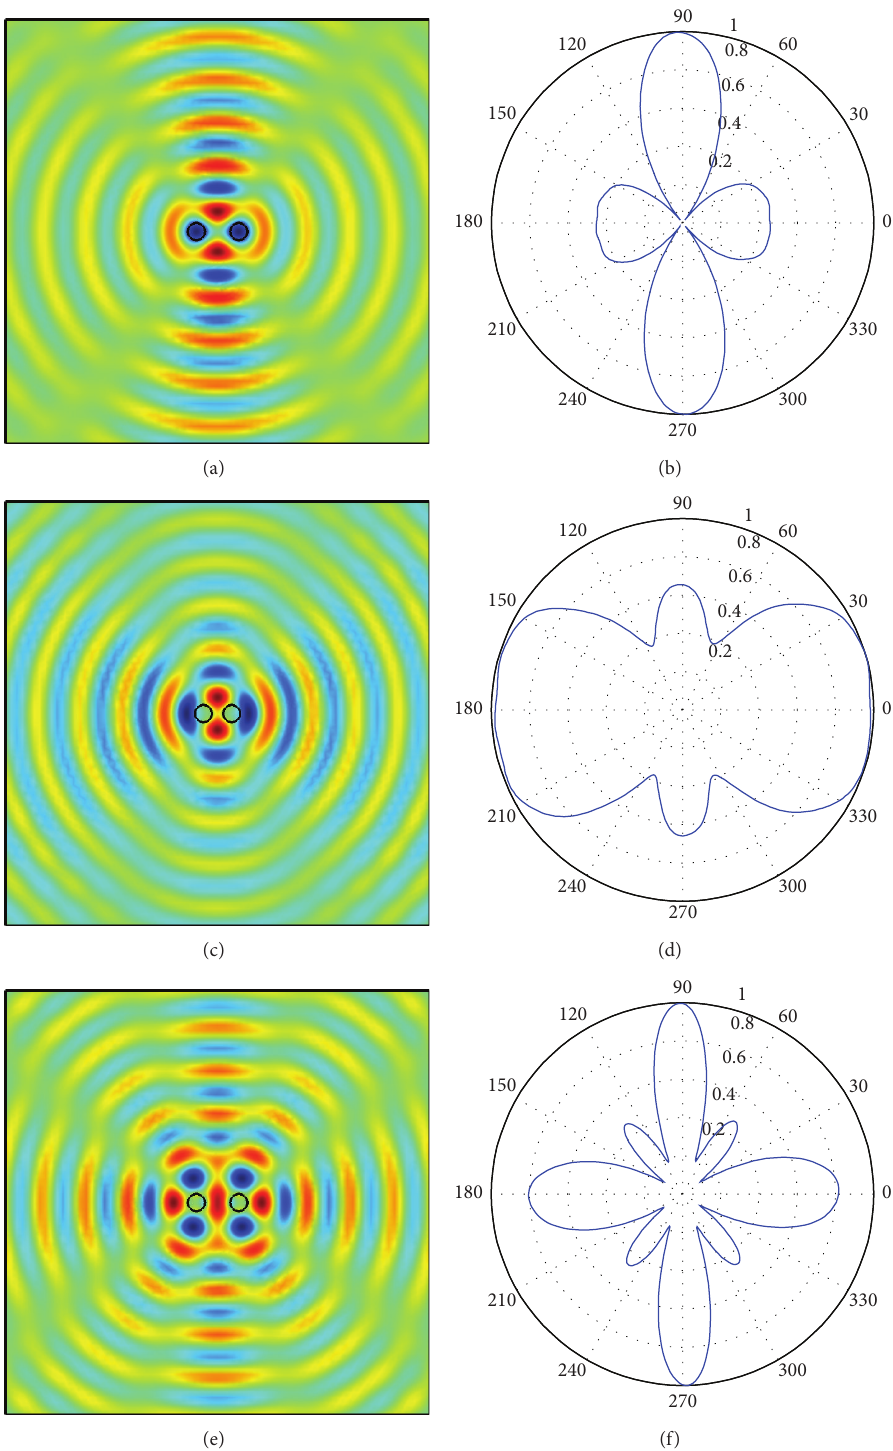
Figure 5: ((a), (c), and (e)) The electric field distribution in the 𝑥 - 𝑦 plane, where mode 𝑛 equals 0, 1, and 2, respectively (color online). ((b), (d), and (f)) The corresponding far-field radiation pattern of (a), (c), and